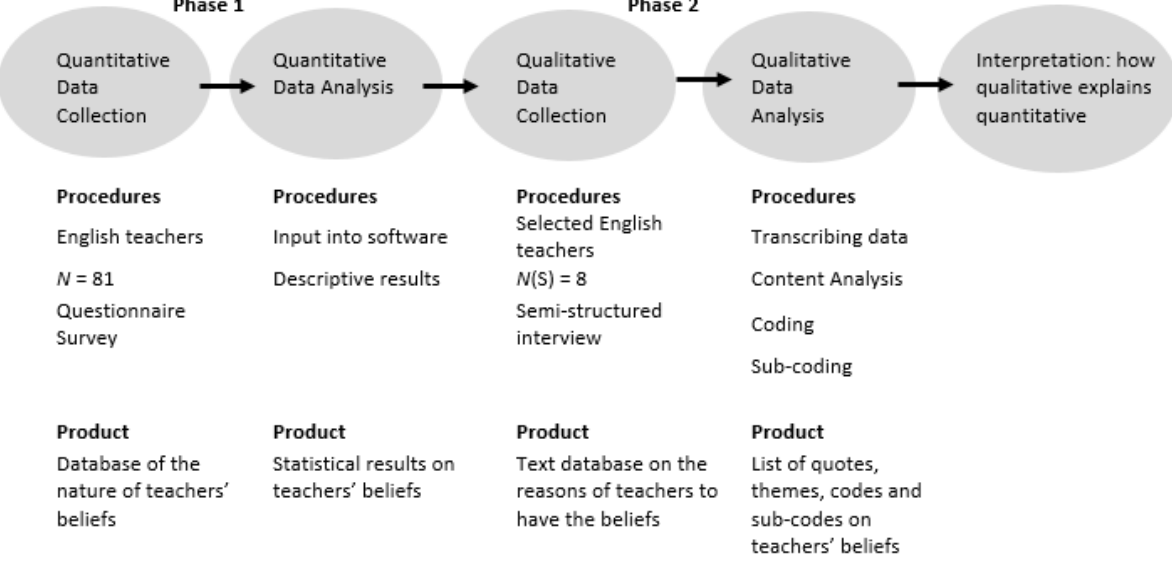
Figure 1. The trajectory of a mixed-method study. Adapted from “Turkish high school students’ English demotivation and their seeking for remotivation: A mixed-method research,” by C. Akay, 2017, English Language Teaching, 10 (8), p.111. Copyright 2006-2018 by the Canadian Center of Science and Education.